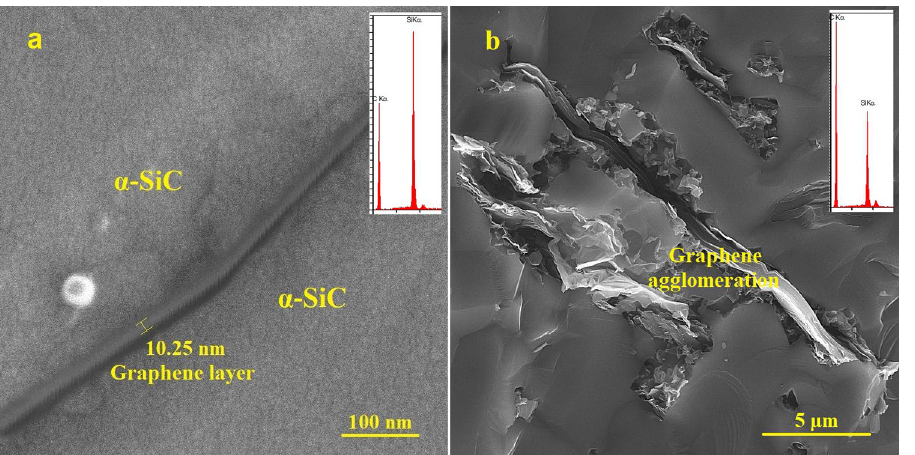
Figure 8. FESEM images of ( a ) 5B1G sample and connection of graphene layer with α-SiC matrix and ( b ) 10B3G sample and graphene